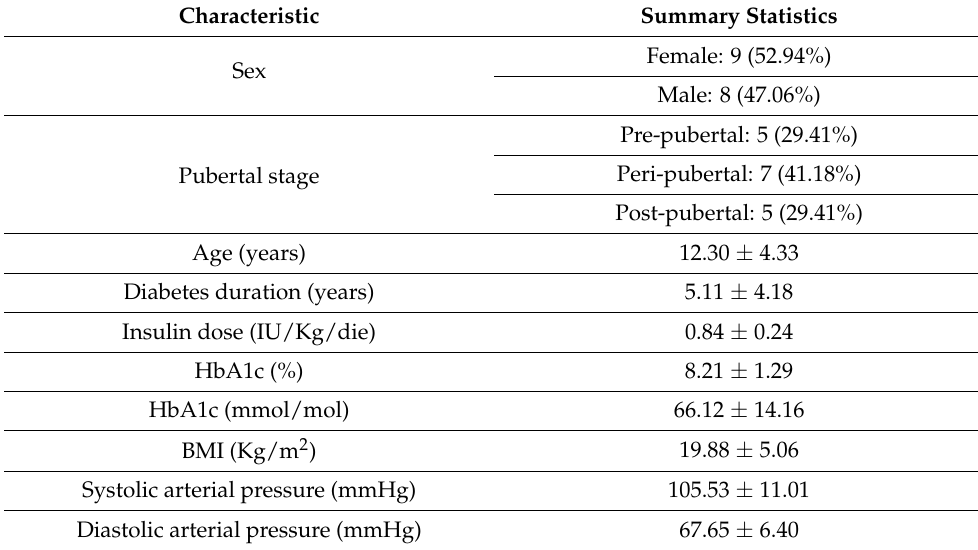
Table 1. Study participant’s characteristics at baseline. Summary statistics are presented as frequency (percentage) and mean ± standard deviation. HbA1c: glycated hemoglobin; BMI: Body Mass